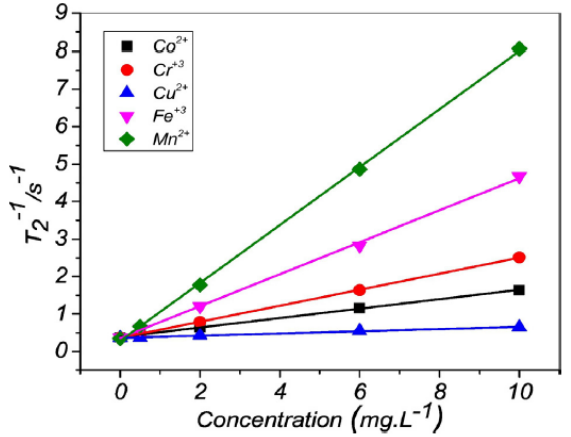
Figure 1. Variation of transverse relaxation rate (T 2 − 1 ) of the water versus the concentration of Co 2 + , Cr 3 + , Cu 2 + , Fe 3 + and Mn 2 + in the solutions. Reprinted from Publication [21], Copyright (2018), with permission from